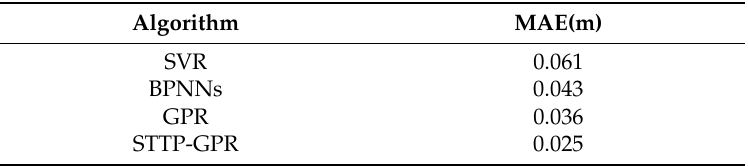
Table 1. Mean absolute error.